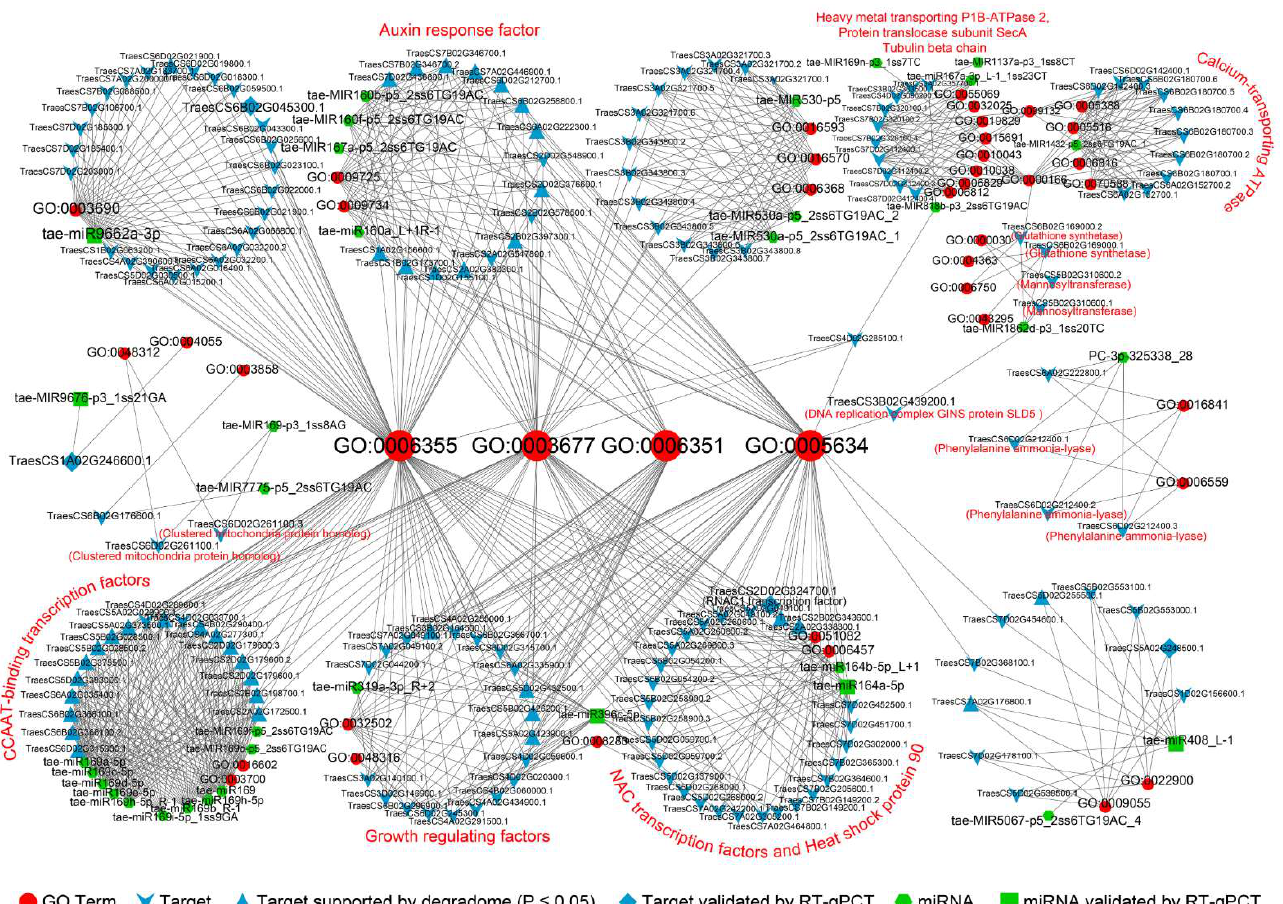
Figure 5. The miRNA-gene-GO association analysis of drought memory-related miRNAs. Candidate drought memory-related miRNAs, their target transcripts, and annotated GO terms were used to investigate the relationship between them. The miRNAs are denoted in green, target transcripts are denoted in cyan, and the GO terms are red. The annotated functions of target transcripts are labeled in red.